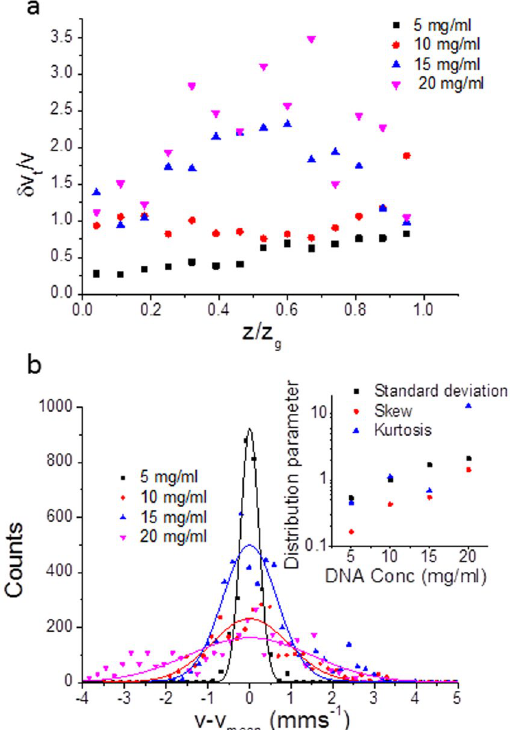
Figure 5. ( a ) Reduced velocity fluctuations ( δ v / v ) as a function of normalized distance ( z / z g ) across the rheometer gap (500 μ m) for different concentrations of high salt DNA solution sheared at 60 s − 1 , measured for long time distributions of the velocity. ( b ) Histograms (proportional to the probability distribution function) of long time (1 s) velocities, measured close to the lower plate of the rheometer, for solutions with a range of DNA concentrations at high salt with an applied shear rate of 60 s − 1 . Gaussian fits are plotted for each data set to aid the eye, although the probability functions are only well described by Gaussians at low DNA concentrations. Fat-tailed distributions occur at high DNA concentrations. The velocities ( v ) are plotted as a function of their distance from the mean velocity ( v mean ) to allow for the slight effects of wall slip. The inset shows the absolute values of characteristic statistical parameters of the velocity distribution as a function of DNA concentration averaged over the entire rheometer gap i.e. standard deviations (black squares), skewes (red circles) and kurtosises (blue